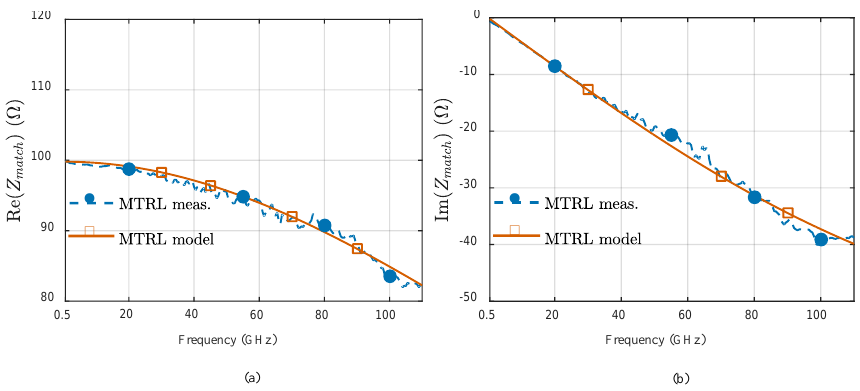
Figure 5. Real ( a ) and imaginary ( b ) part of the 100 Ω match impedance. “MTRL meas.” denotes the impedance measured with MTRL calibration, and “MTRL model” denotes the impedance fitted from “MTRL - meas.”